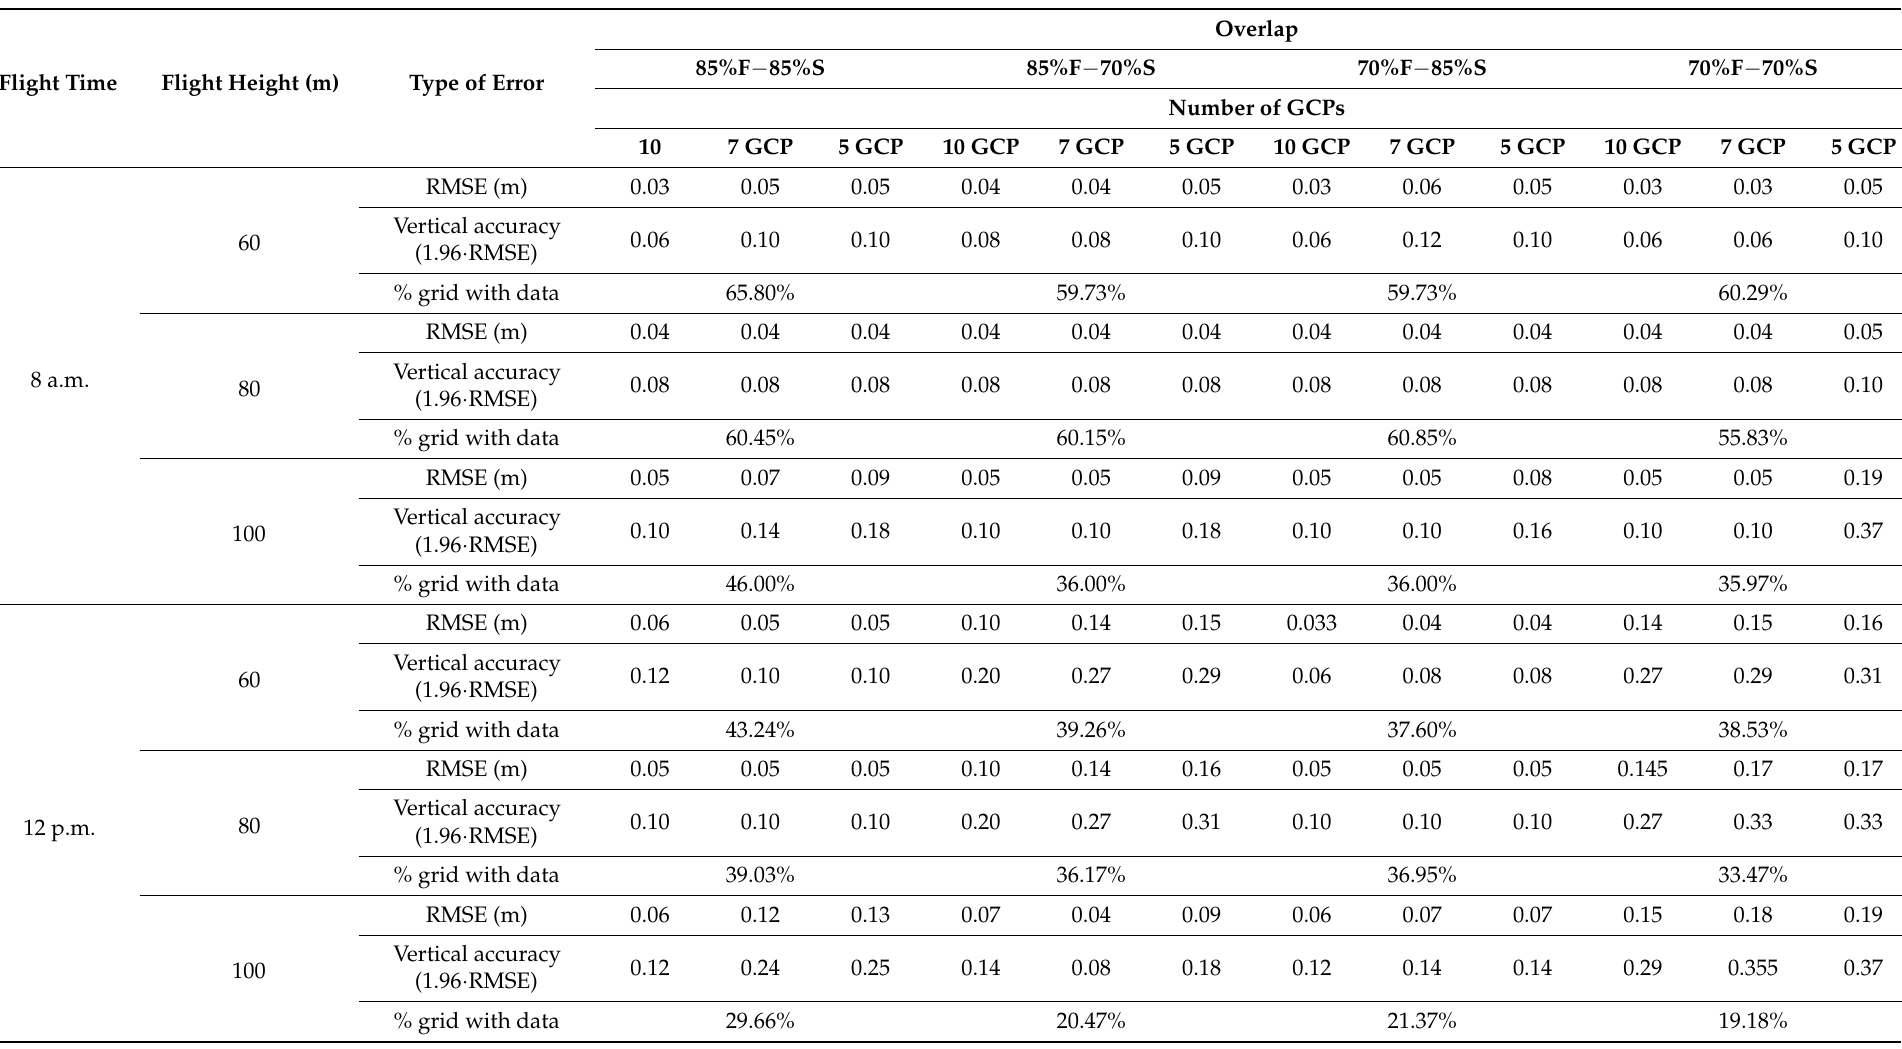
Table 4. Different kinds of errors (RMSE, vertical accuracy, percentage of grids with homogeneous points) for data for different side (S) and forward (F) overlap and for different flight height, flight time, and number of